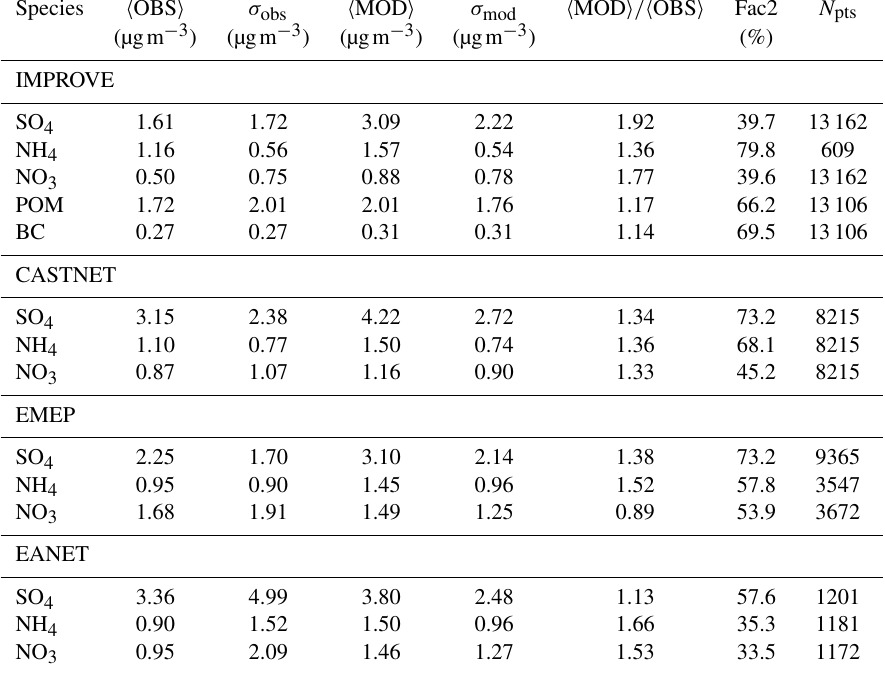
Table 3. Summary of the model–observations statistical comparison of monthly mean near-surface aerosol concentrations from the EMAC simulation with MADE3 and station network data. (cid:104) OBS (cid:105) ( (cid:104) MOD (cid:105) ) stands for the arithmetic mean over all data points of the observations (simulation), σ obs ( σ mod ) for the standard deviations, Fac2 for the percentage of simulated values that are within a factor of 2 of the cor- responding observational values (i.e., 0 . 5OBS ≤ MOD ≤ 2OBS), and N pts for the number of data points, i.e., monthly averages, that went into the comparison. See Appendix A2 in Righi et al. (2013) for more details about the methodology.